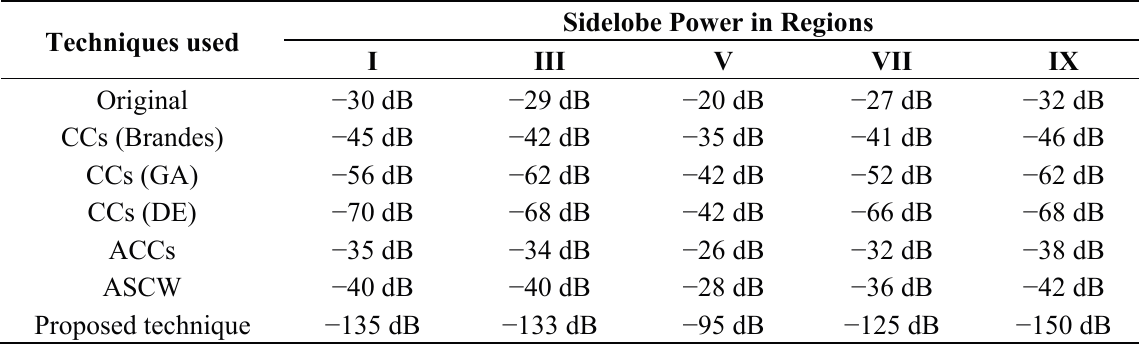
Figure 13. The PSD comparison between the proposed technique and existing techniques including CC (Brandes), CC (GA), and CC (DE). Table 5. Comparison of sidelobe suppression between existing and proposed